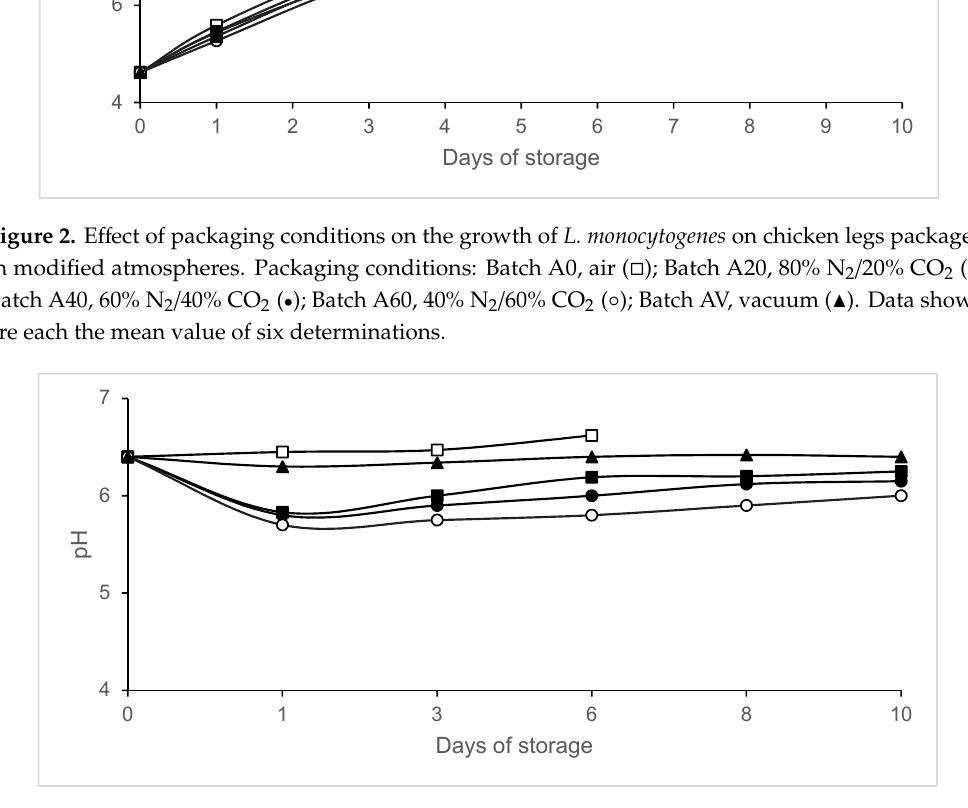
Figure 3. The evolution of pH in chicken legs packaged in modified atmospheres. Packaging conditions: Batch A0, air ( □ ); Batch A20, 80% N 2 /20% CO 2 ( ▪ ); Batch A40, 60% N 2 /40% CO 2 ( • ); Batch A60, 40% N 2 /60% CO 2 ( ◦ ); Batch AV, vacuum ( ▲ ). Data shown are each the mean value of six determinations. Changes in package atmospheres (O 2 , CO 2 , N 2 ) were not significant ( p > 0.05) during